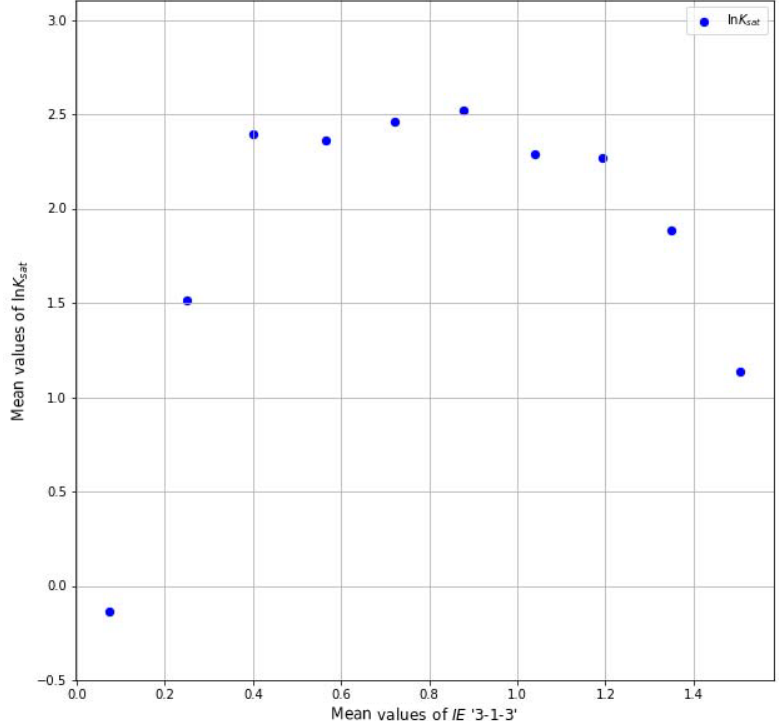
Figure 5. ln K sat values against IE calculated with the “3-1-3” triplet in 10 interval binnings.